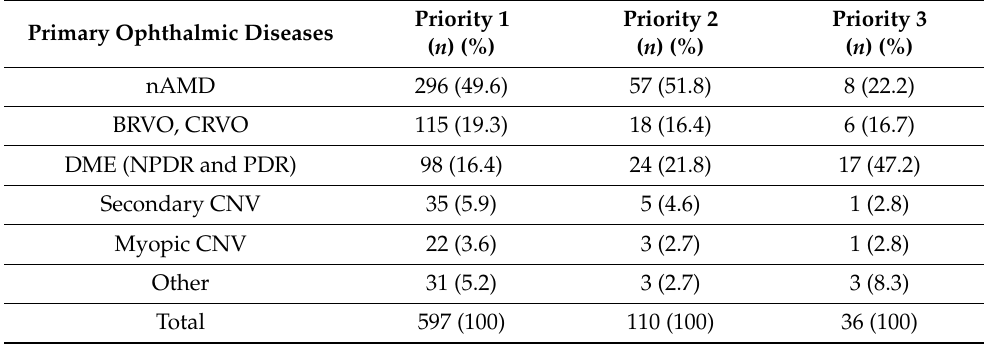
Table 1. Primary ophthalmic diseases of patients in numbers and percentage for each priority group. Priority Primary Ophthalmic Diseases